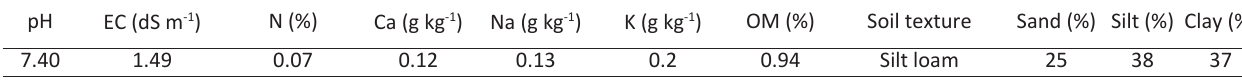
siteOM= Organic matter.